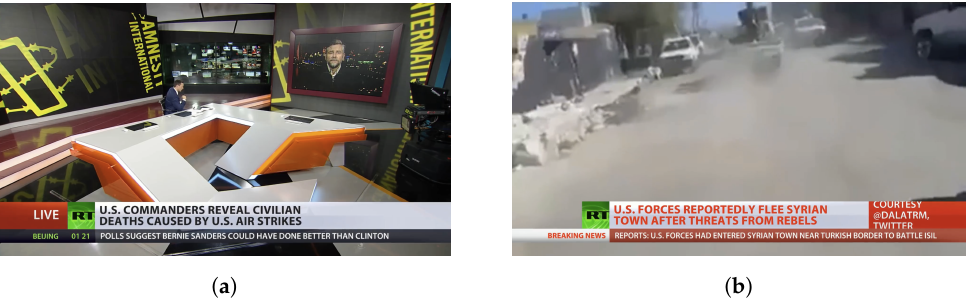
Figure A1. Samples of professional content vs. “in the wild” content. ( a ) Professionally generated content; ( b ) “In the wild” content. Table A1. Indicators of professional content vs. “in the wild”